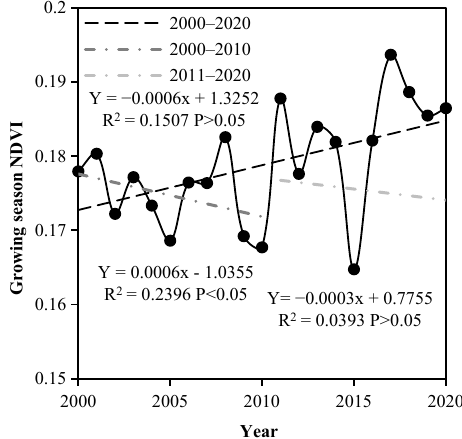
Figure 3. The variation of the NDVI in the SWTP.